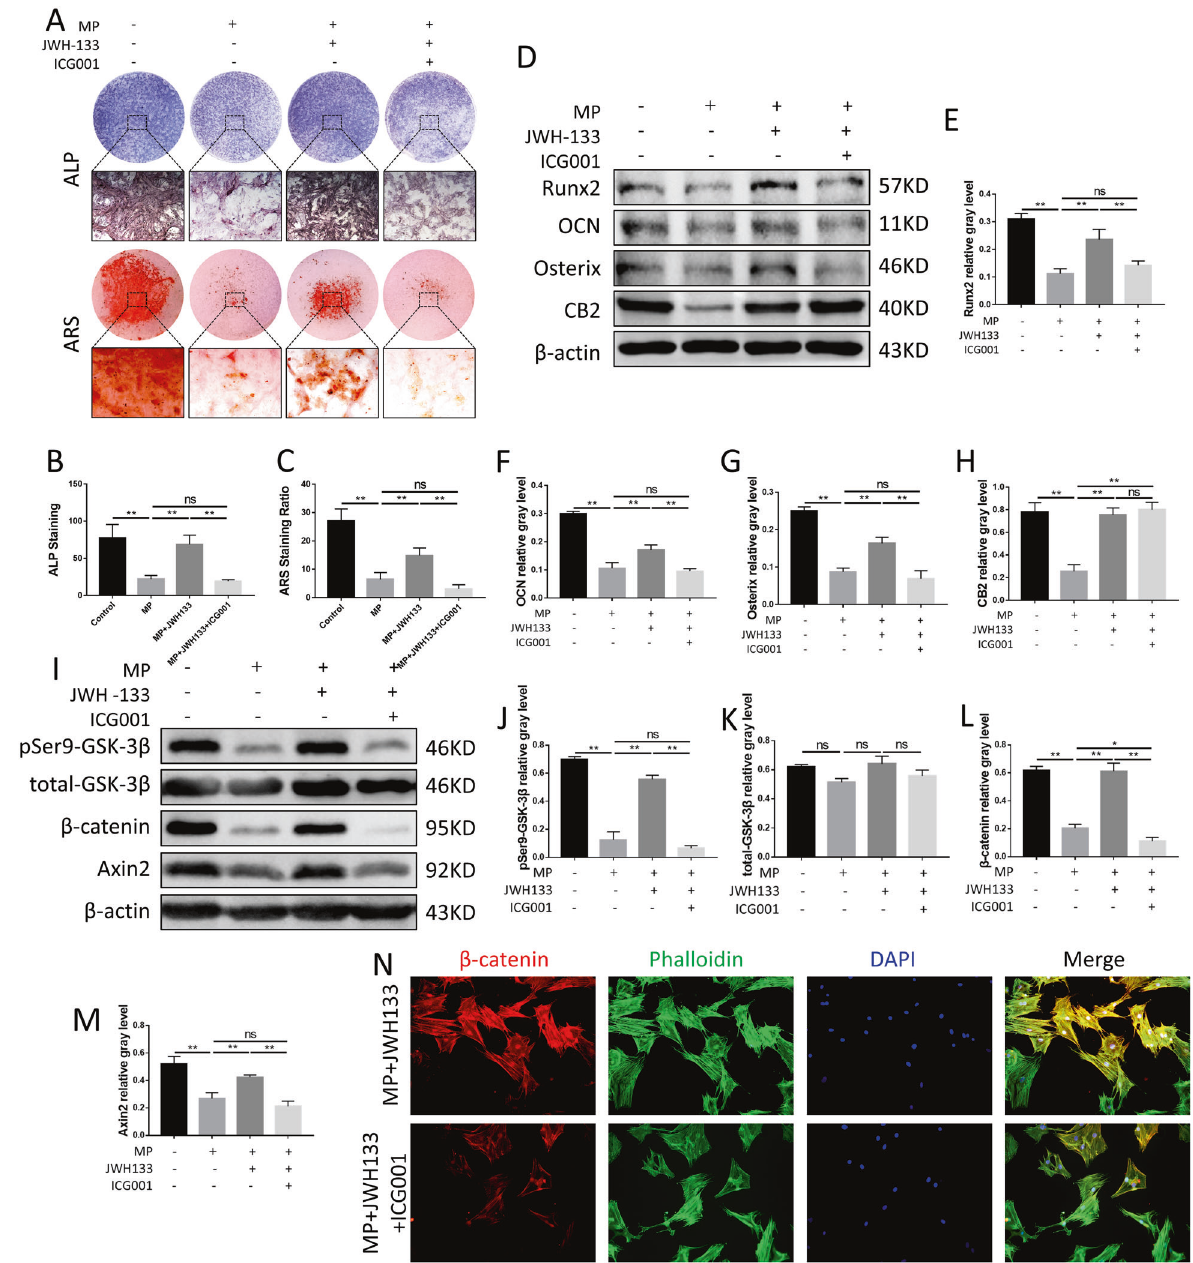
Fig. 6 Inhibition of Wnt/ β -catenin signaling pathway reversed the osteogenic protective effect of CB2. A – C ALP, ARS staining and analysis, n = 3 per group. D – H Protein expression levels of Runx2, OCN, Osterix, and CB2, n = 3 per group. I – M Expression levels of pSer9-GSK-3 β , total GSK-3 β , Axin2, and β -catenin, n = 3 per group. N Immuno fl uorescence staining, red ( β -catenin), green (phalloidine), blue (nuclei) (data are shown as mean ± SD, * p < 0.05; ** p < 0.01; ns, not signi fi blood vessel formation. Compared with the control group, MP correlated with the inhibition rate of HUVECs (Fig. S7A, B). When showed obvious anti-angiogenesis effect. JWH133 reversed the intervened within safe doses of MP for 48 h, there was also a inhibitory effect of MP on angiogenesis and enhanced the loop- meaningful CB2 expression difference in HUVECs (Fig. 8A, B). The forming ability of HUVECs. The quantitative results displayed the western blot results showed that CB2 expressions were subjected total meshed area, total length, and number of branching points by MP, JWH133, and AM630 (Fig. 8C, D). The scratch assay clearly (Fig. 8I – L). The results showed that bevacizumab (0.5 μ g/mL) showed that at 12 and 24 h, the healing ability of the MP group signi fi cantly inhibited the migration ability and tube formation was signi fi cantly slower than that of the normal group, while activity of HUNECs in JWH133 group, indicating that the effects of JWH133 inhibited this effect of MP (Fig. 8E, F). The transwell assay CB2 on the HUVEC cells can be blunted by VEGF neutralizing results showed that GC seriously damaged the migration activity antibody (Fig. S7C-J). These fi ndings indicate that CB2 activation of HUVECs, and CB2 agonists relatively made up for this damage can promote endothelial cell migration and angiogenesis in vitro. (Fig. 8G, H). Tube formation test can directly re fl ect the ability of